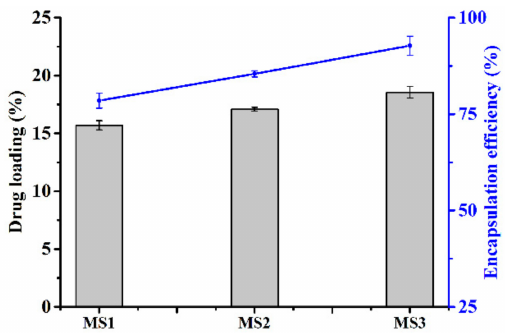
Figure 7. Effect of particle sizes on drug loading and encapsulation efficiency.